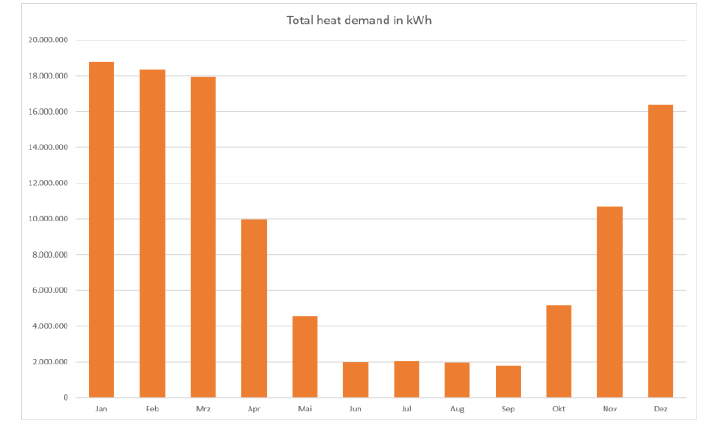
Figure 3. Total heat demand per month in